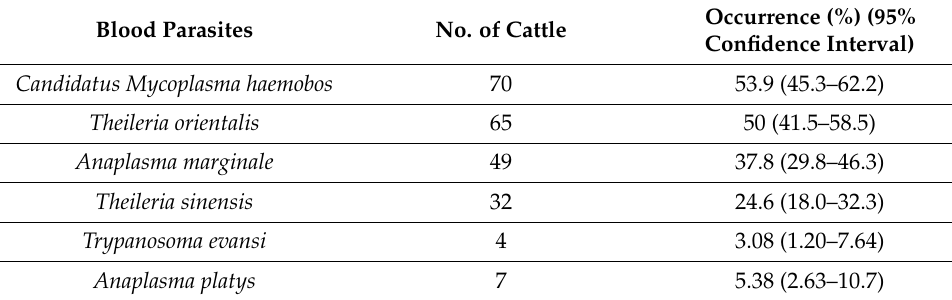
Occurrence (%) (95% Confidence Interval)